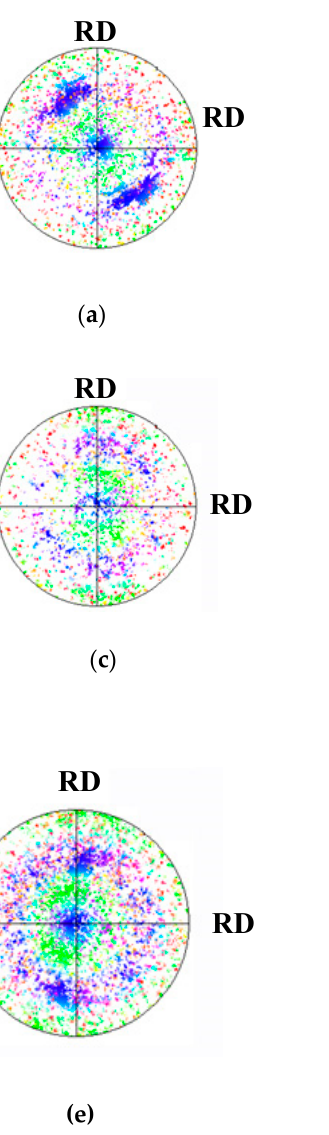
Figure 6. {1010} pole figures obtained from the EBSD image of Figure 5 of the extruded GWZ831 alloy after ( a ) 0, ( b , c ) 4, and ( d , e ) 6 ECAP passes. Extrusion or ECAP direction is perpendicular to the image.